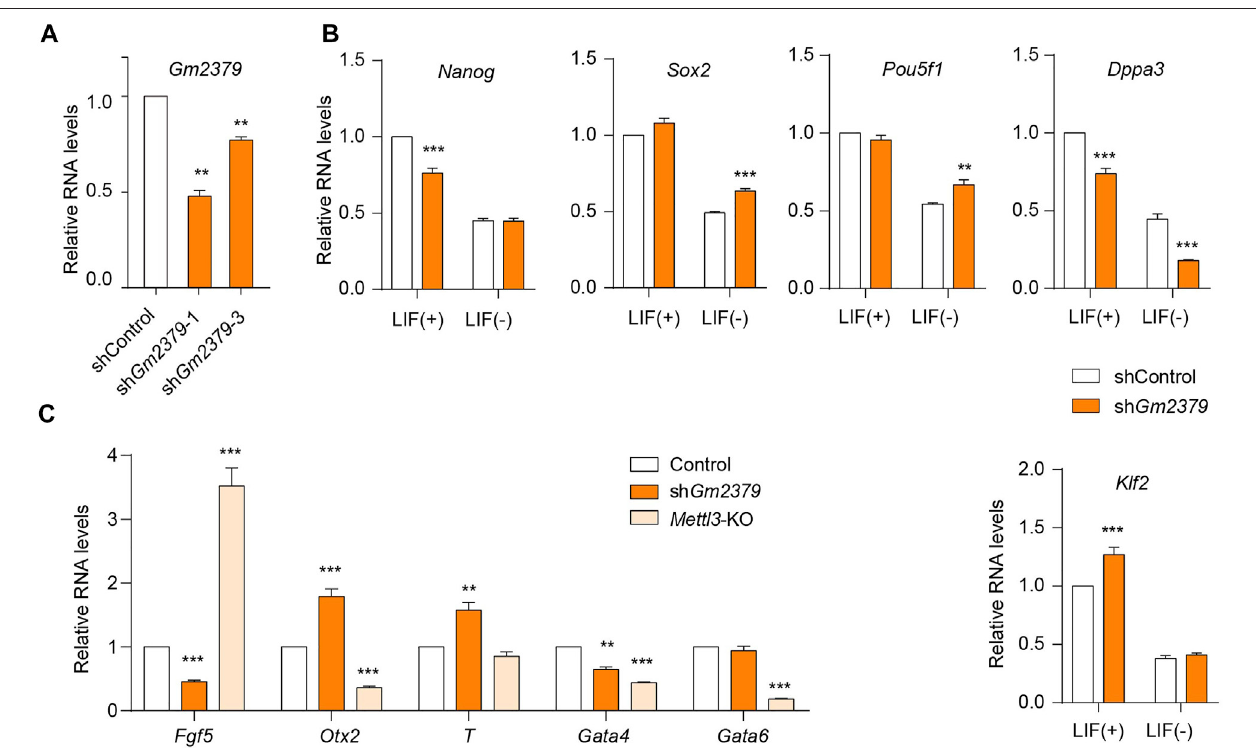
FIGURE 6 | Gm2379 modulates the expressions of pluripotent and germ-layer genes. (A) Generation of Gm2379 -KD ESCs. (B) Detection of transcript levels of pluripotentgenesincontroland Gm2379 -KDESCsinthepresenceorabsenceofLIFbyRT-qPCR. (C) Detectionoftranscriptlevelsofthreegerm-layergenesincontrol, Gm2379 -KD and Mettl3 -KO ESCs by RT-qPCR. sh Gm2379 -1 ESCs were used in (B) and (C) . Error bars, mean + SEM; n = 4 independent replicates; * p < 0.05, ** p < 0.01, *** p <